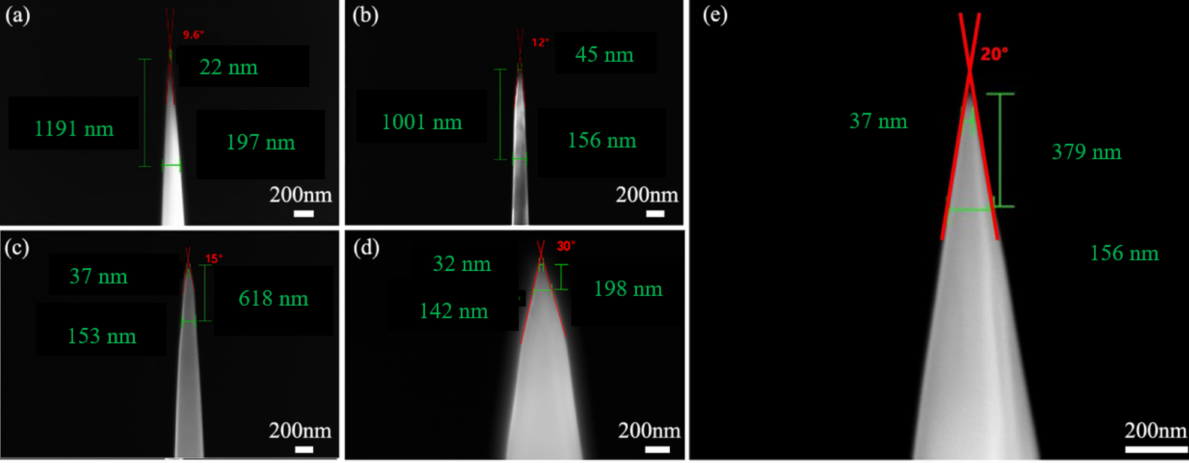
Figure 7. Example of the single-wedge lift-out APT specimen tip shape. ( a ) Tip 9 ◦ ; ( b ) tip 12 ◦ ; ( c ) tip 15 ◦ ; ( d ) tip 30 ◦ ; ( e ) tip 20 ◦